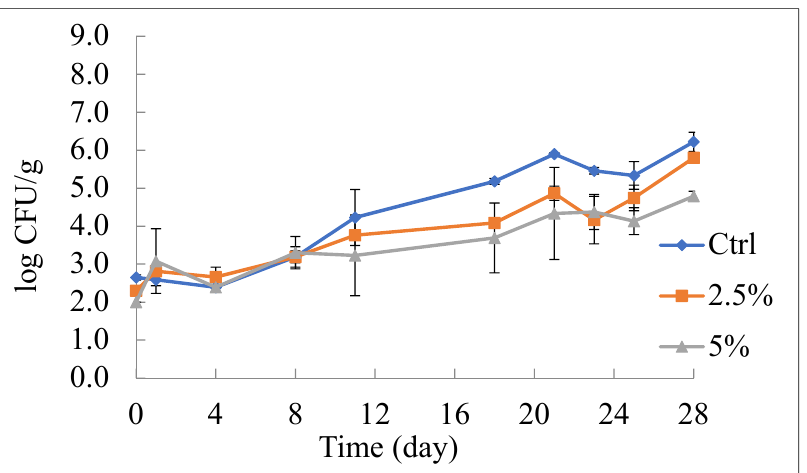
Figure 2. Evolution of yeasts in fruit salad during 28 days of refrigerated storage (5 °C). Ctrl: fruit salad without pomegranate peel powder; 2.5%: fruit salad with 2.5% ( w / v ) pomegranate peel powder; 5%: fruit salad with 5% ( w / v ) pomegranate peel powder.